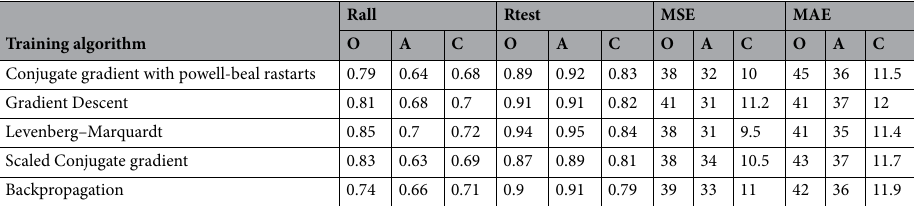
Table 2. The results of other